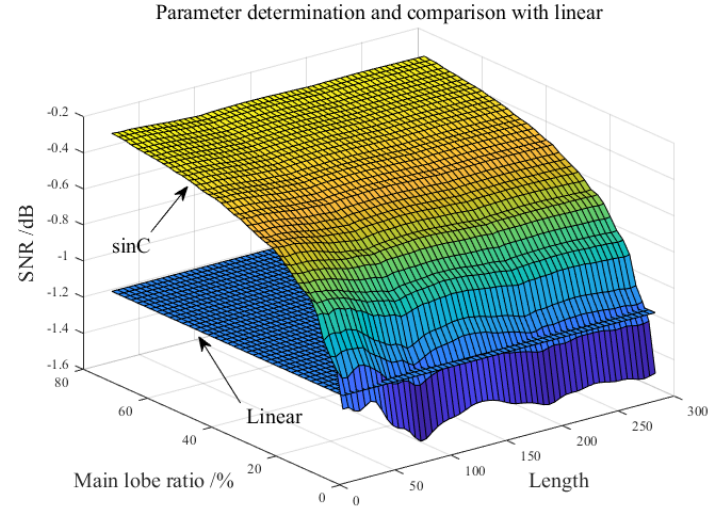
Figure 3. The parameter selection and its influence on filtering effect and compared with linear.